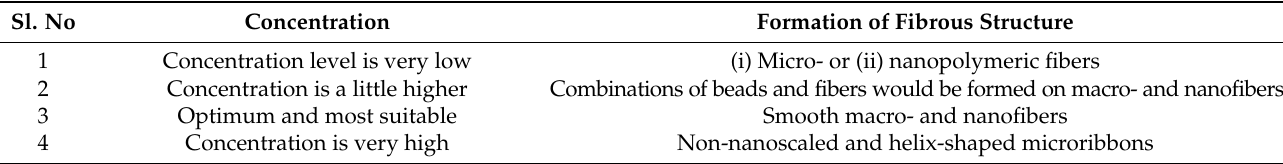
Table 3. Comparison of the different concentrations [23].